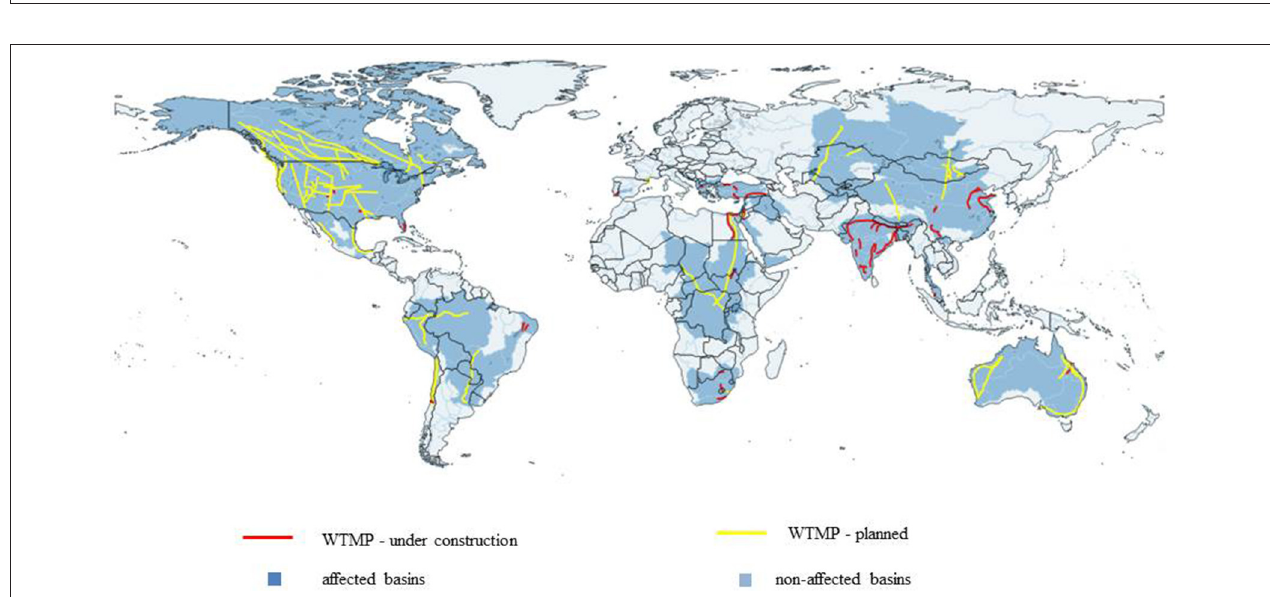
FIGURE 2 | Distribution of future WTMP according to their purposes: water supply for purposes of agriculture (green lines, N = 43), hydropower development (orange lines, N = 13) or both (orange-green stripped lines, N = 10). Blue lines show major rivers.